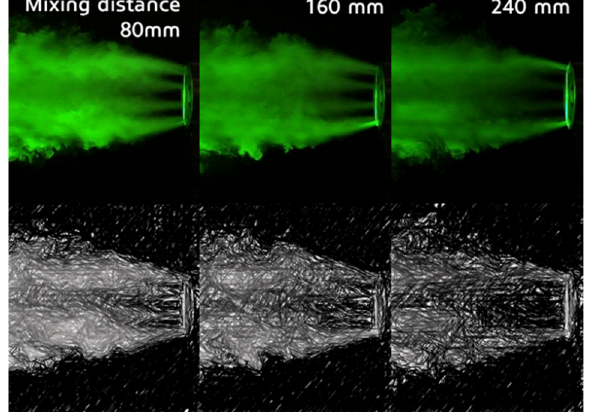
Figure 5. Comparison of the visualized images for the various mixing distances. (“c”